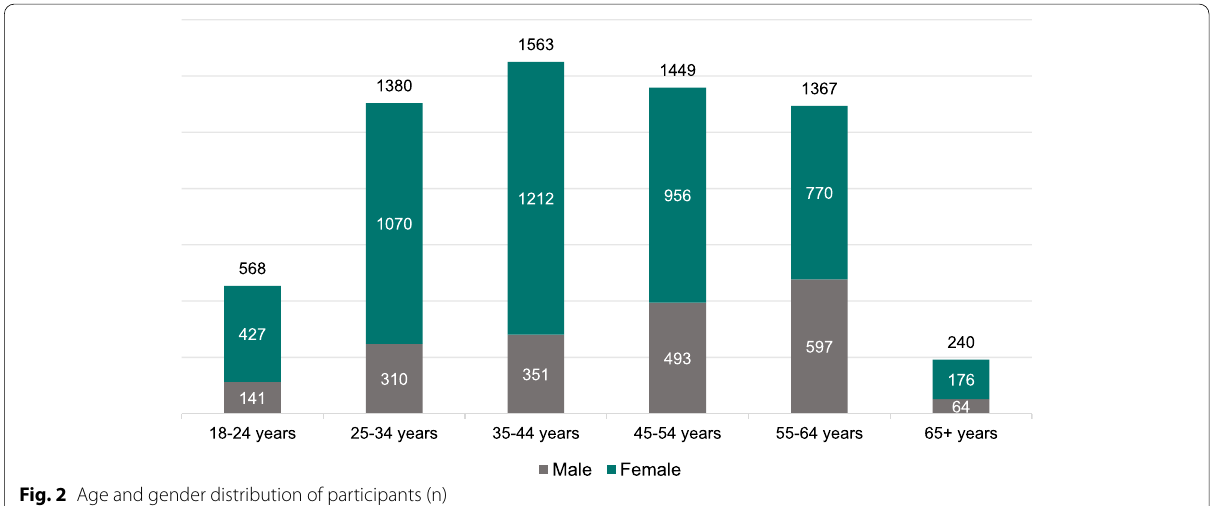
Fig. 2 Age and gender distribution of participants